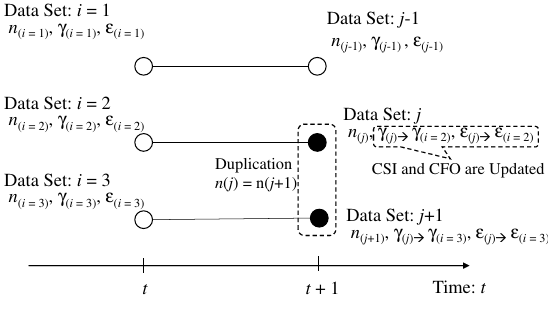
Figure 5. Updating of data set after labeling with duplication of sensing